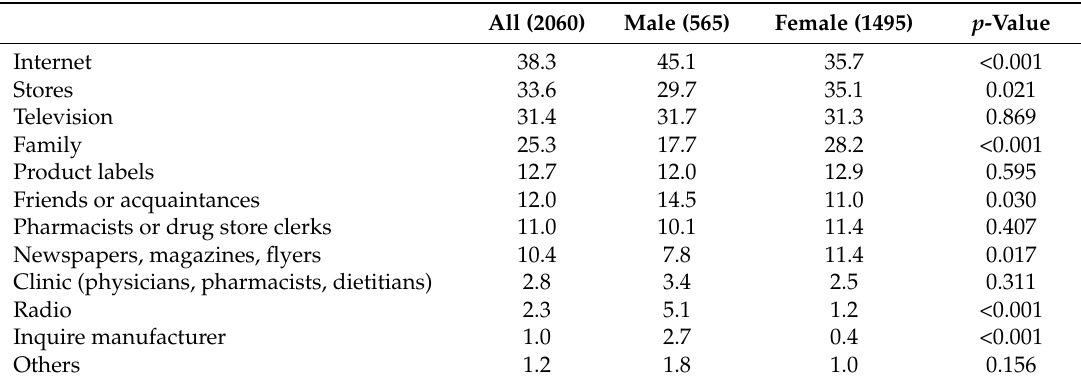
Table 3. How do you get information about dietary supplements? (%).